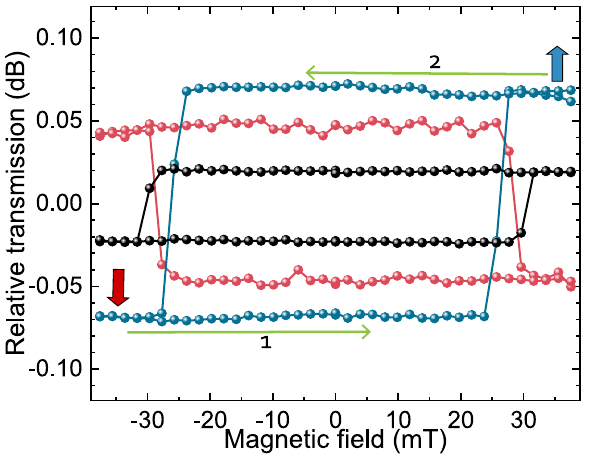
Figure 4: Hysteresis behaviour observed in the mode-specific transmission as a function of the applied magnetic field when fully TE-mode input light is used. Plots show different magneto-photonic and L ), albeit with the same devices (with varying lengths of L rect. tri. magnetic cladding length of 600 nm. Prior to the measurements, the memory state of the cladding is set by applying − 40 mT field. Then, the magnetic field is swept in the direction and order indicated by the horizontal arrows. The jumps in the relative transmissions (at approximately ± 30 mT), correspond to the switching of the magnetization direction of the claddings, thus changing of the , L ) length parameters in memory states. The combinations of ( L rect. tri. μ m are (7.77, 4.3), (7.77, 1.0) and (5.07, 2.2); for blue, red and black data-sets,